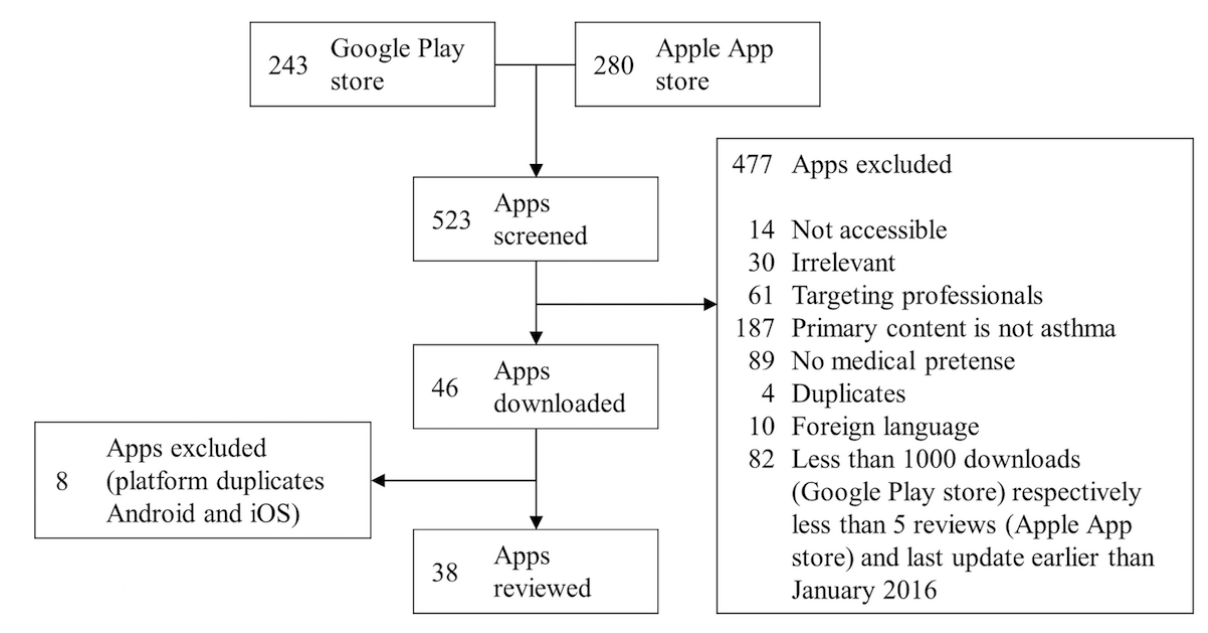
Figure 1. Systematic search and exclusion